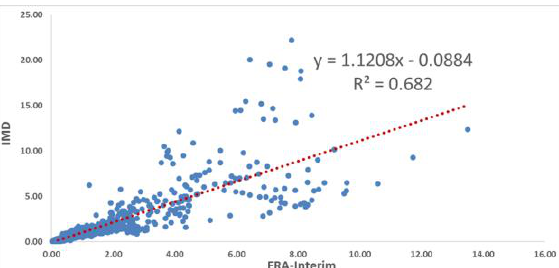
Figure 8. Scatter plot between daily rainfall in MAM season of Era-Interim and IMD rainfall products